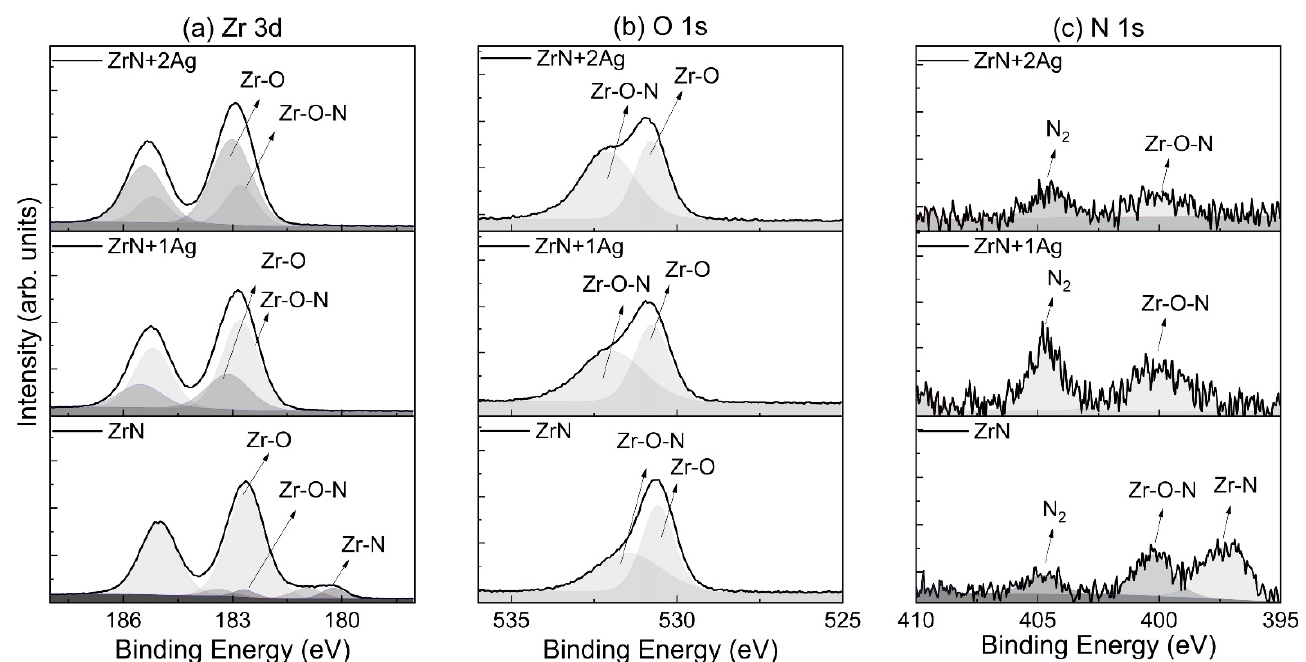
Figure 2. XPS spectra of ( a ) Zr 3d, ( b ) O 1s, and ( c ) N 1s of the ZrN, ZrN+1Ag, and ZrN+2Ag coatings.